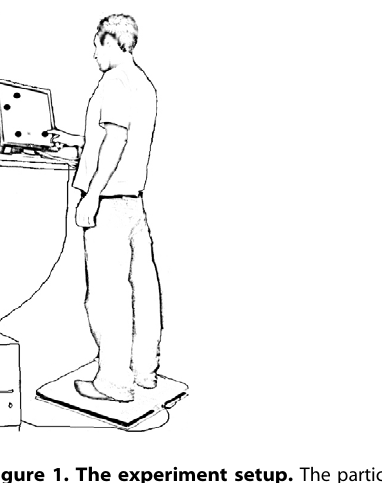
Figure 1. The experiment setup. The participant was instructed to stand on the forceplate in a quiet stance position, in front of the touch screen. The forceplate’s output data was streamed into the same desktop PC that presented and controlled the touch sequence